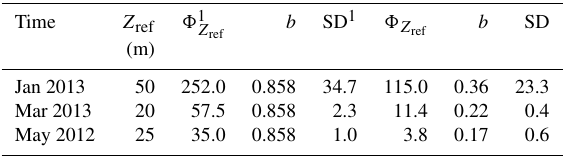
Table 3. Martin curve fit